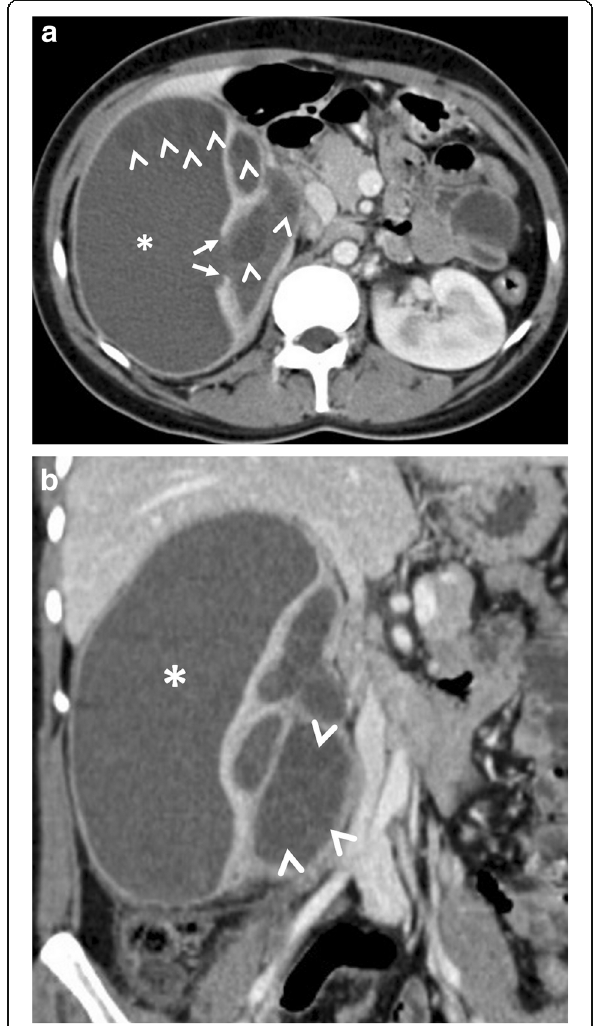
patchy areas of decreased attenuation migrating from liver capsule through to deep parenchyma (arrows, a , b ). Although not confirmed histopathologically, imaging-based diagnosis of F . hepatica